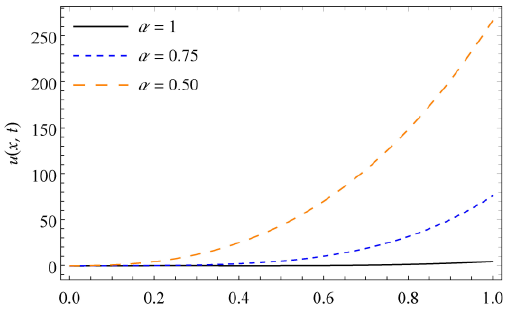
Figure 4. Surfaces of ( a) q -HAETM solution (b) Exact solution (c) Absolute error = |𝑢 𝐸𝑥𝑎𝑐𝑡 − 𝑢 𝐴𝑝𝑝. | at ℏ = −1,𝐵 0 = 1,𝜆 = 2,𝑎 = 1, 𝑛 = 1, and 𝛼 = 1 .